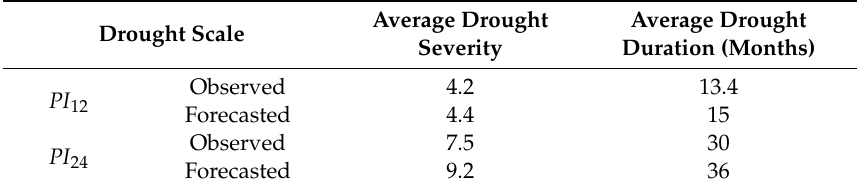
Table 3. Observed and forecasted drought severities and durations for 12- and 24-month drought time